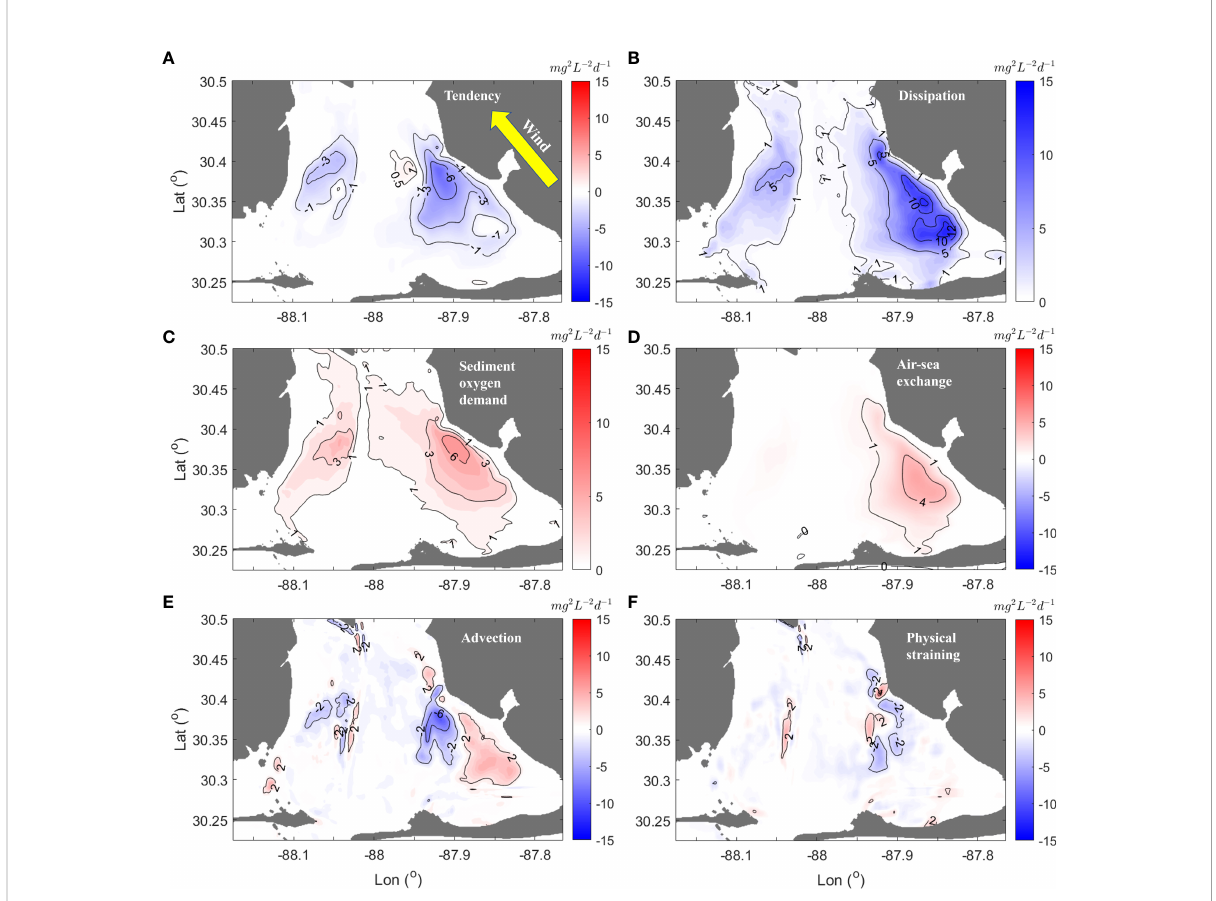
FIGURE 10 Terms in the vertical dissolved oxygen variance (VDOV) budget (mg 2 L -2 d -1 ) during a southeast wind event. Panel (A – F) are spatial patterns of corresponding terms of VODV budget equation (Eq. 4). Red color denotes positive tendency, advection, and physical straining (i.e., increasing VDOV); blue color denotes negative tendency, advection, straining and dissipation (i.e., decreasing VDOV). All terms were temporally and vertically averaged over a 36-hour period between May 8 -